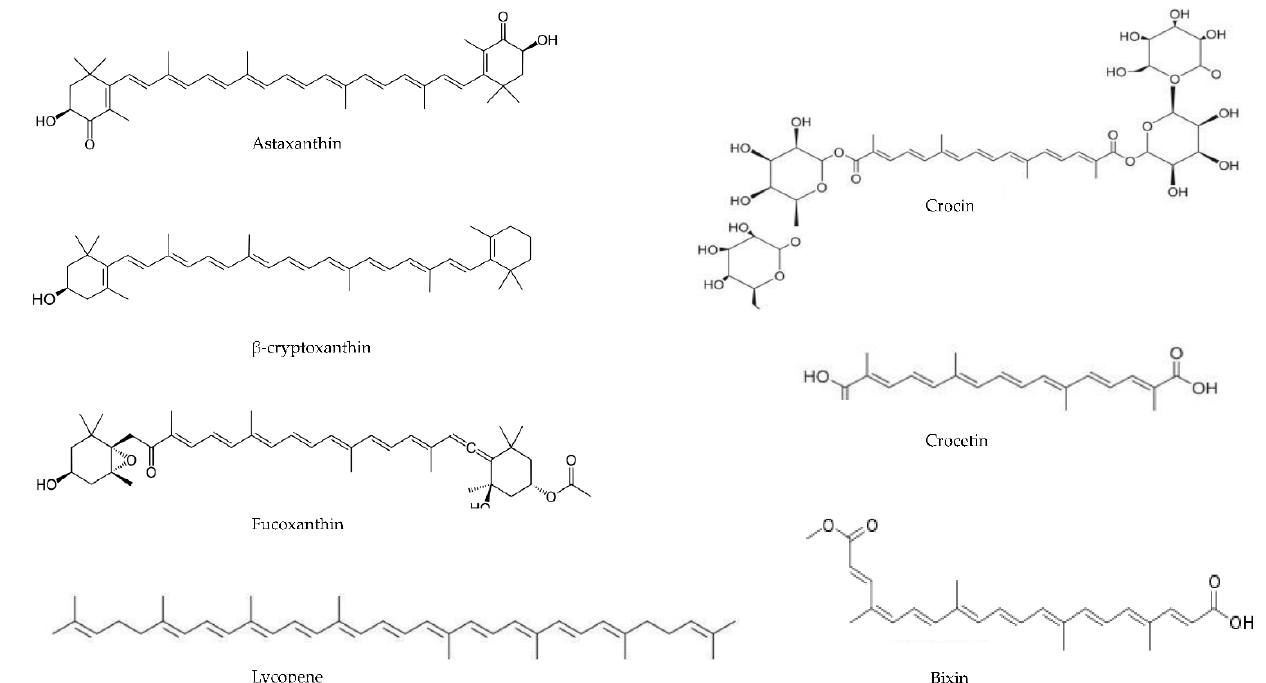
Figure 1. The chemical structures of key carotenoids discussed in the manuscript.